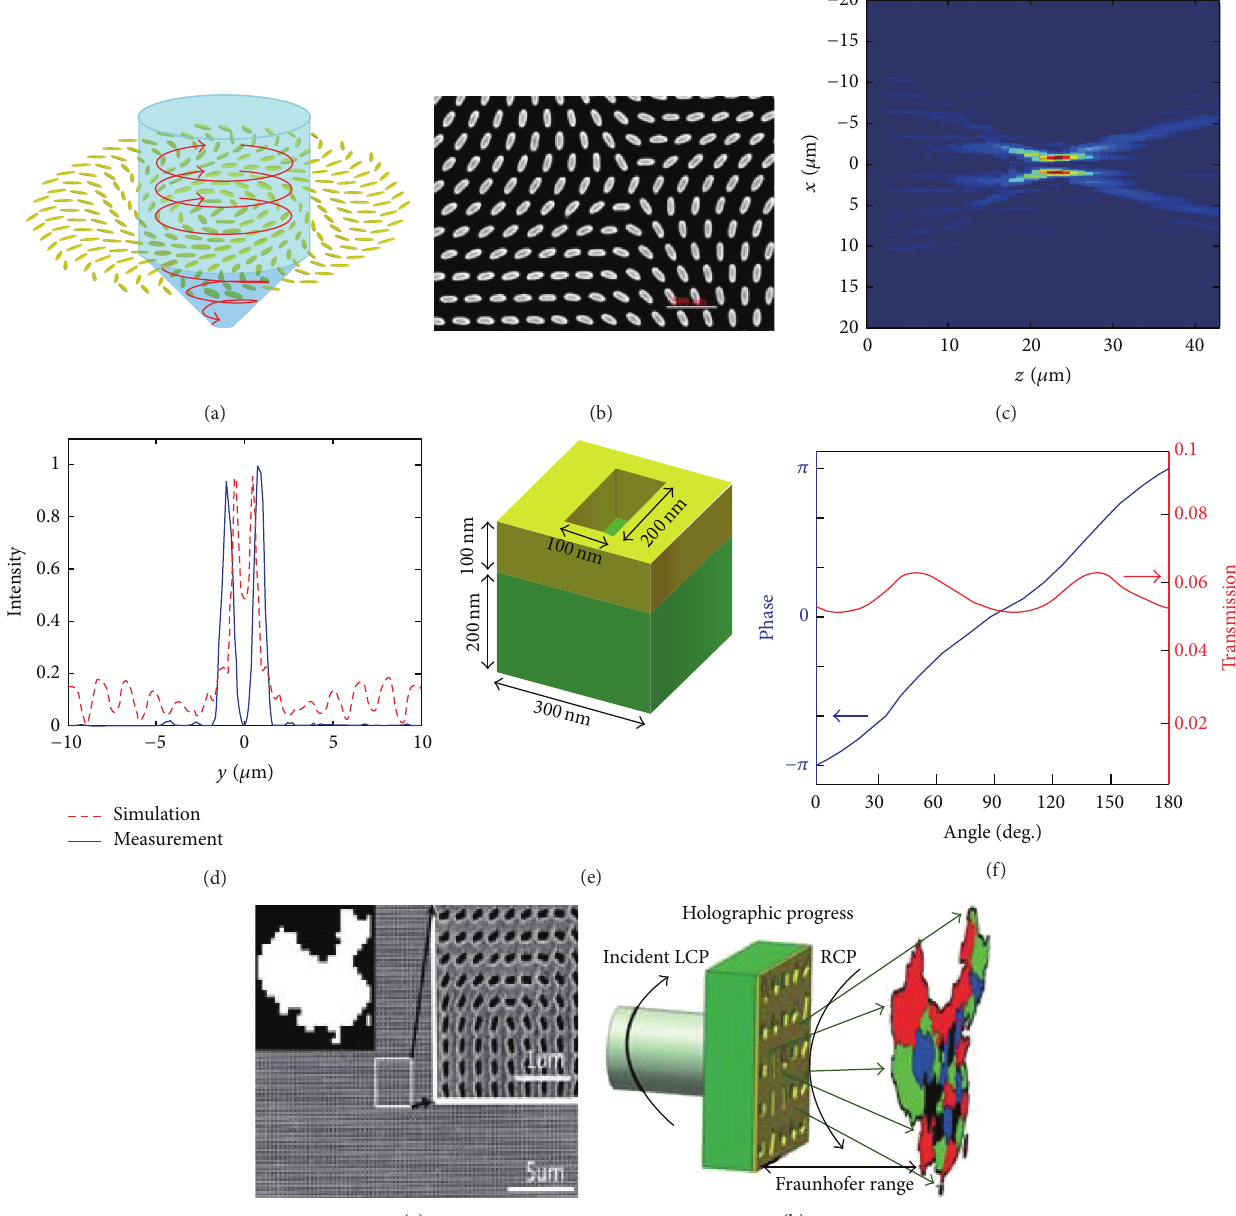
Figure 35: (a) Schematic of the 2D elliptic antennas array. (b) SEM image of the elliptic antennas. (c) Measured power intensity profile of the focused field in the 𝑥𝑧 -plane. (d) The simulated (dashed lines) and measured (solid lines) intensity spectra of the focused field, respectively, along the 𝑦 -direction. (e) Schematic of the unit cell of rectangular aperture in metallic screen for holography. (f) Amplitude and phase transmission for various rotation angles. (g) SEM image of the sample. (h) Schematic of the measurement setup. Figures are reproduced from